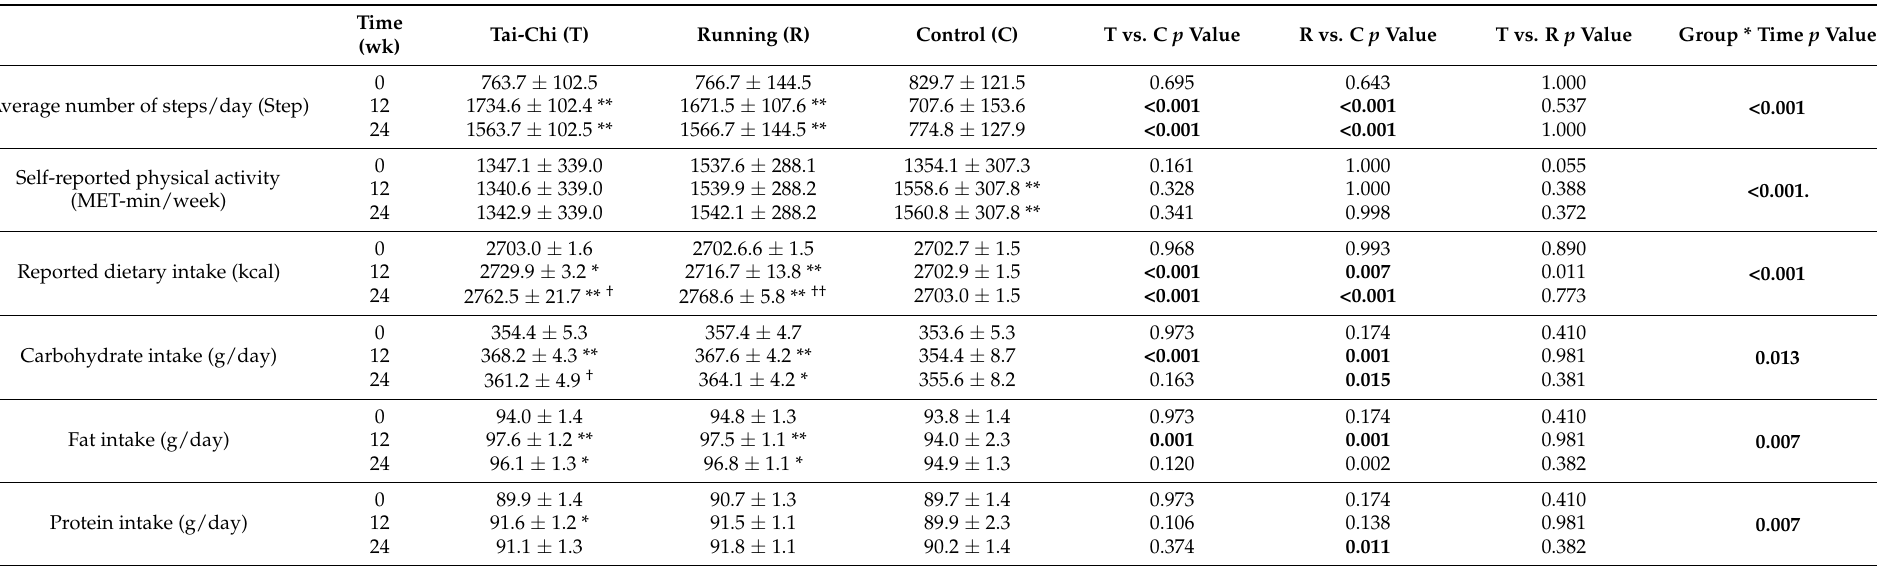
Table 2. Physical activity and nutrient uptake among Tai-Chi ( n = 10), running ( n = 14) and control ( n = 12) groups at baseline, 12-week and 24-week intervention (Mean ± SD). Time Tai-Chi (wk)